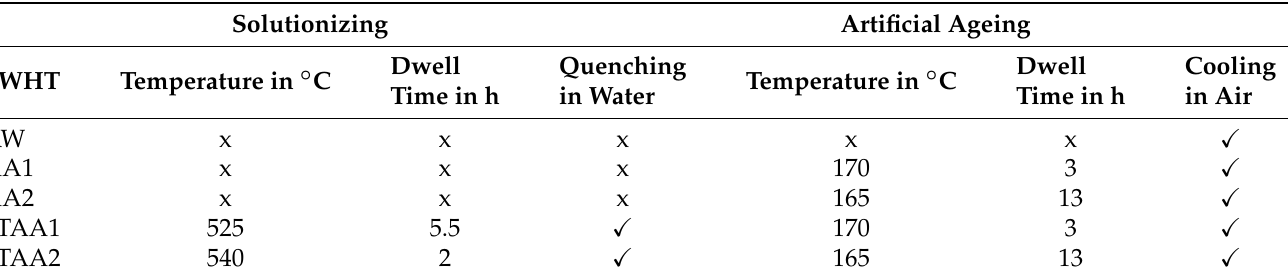
Table 3. The different strategies for PWHT and resulting distinct material conditions.